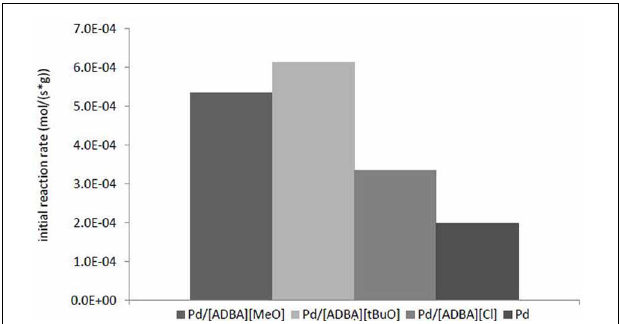
FIGURE 5 | Comparison of the initial reaction rates with various supported ionic liquid catalysts. The initial reaction rates were calculated at 5min from commencing the reaction. All reactions presented here were carried out at T = 100 ◦ C and p ( H 2 ) = 10 bar. The catalysts were Pd in [ADBA][Cl], [ADBA][MeO], and [ADBA][tBuO] on ACC. Pd on ACC is the traditional heterogeneous reference catalyst.